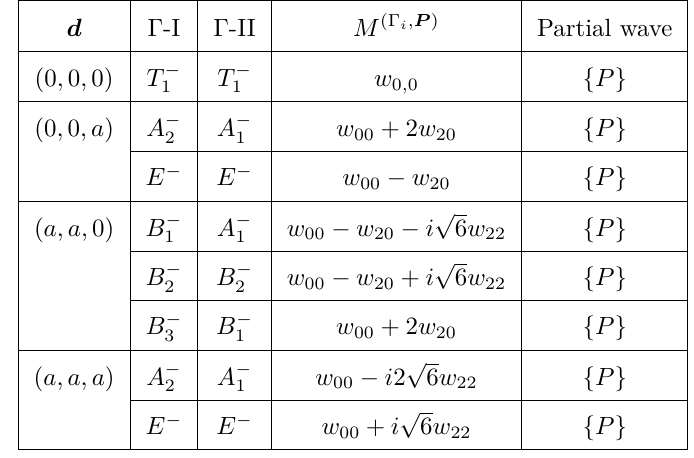
Table 12 . Lüscher’s quantization conditions for systems with odd parity